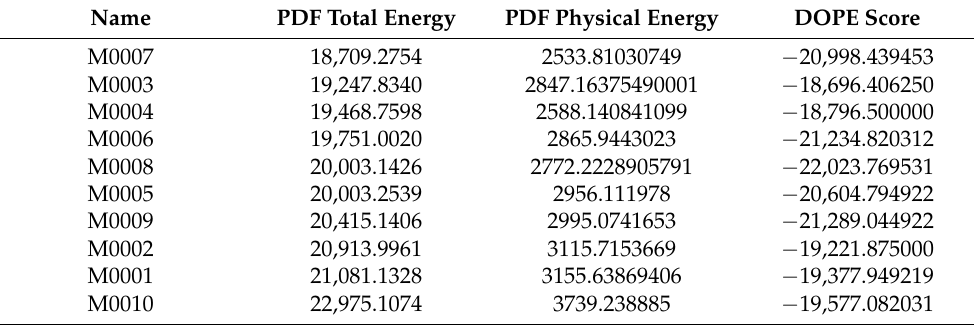
Table 2 . The PDF energy score of the 3D models of eEF2K protein Table 2. The PDF energy score of the 3D models of eEF2K